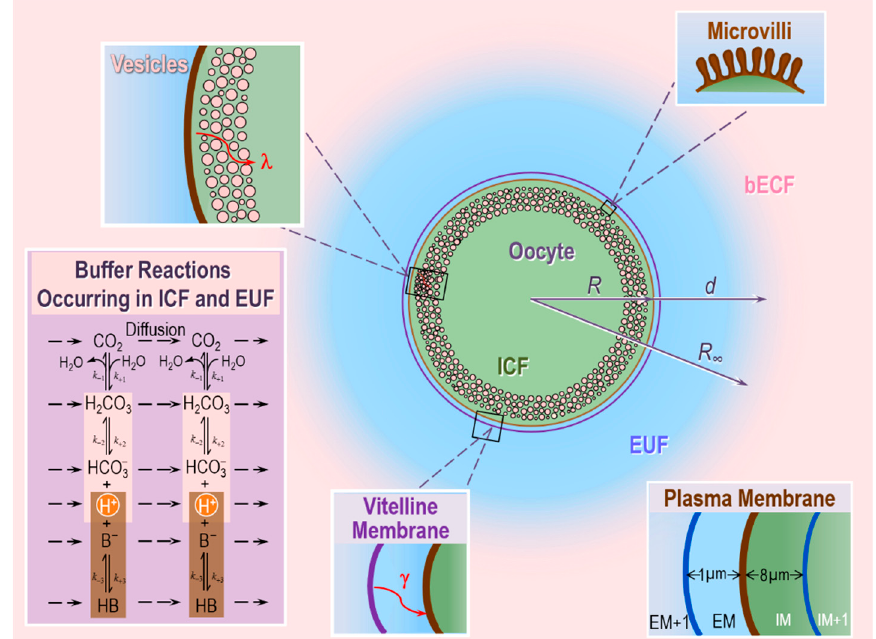
Figure 5 . Key elements of the reaction–diffusion mathematical model of CO 2 fluxes across the plasma membrane of an oocyte. The model includes: a thin layer of vesicles beneath the plasma membrane (inset in top left corner), folds and microvilli at the plasma membrane (PM; inset in top right corner), intracellular and extracellular buffer reactions (inset in bottom left corner), cytosolic water volume that is lower than total intracellular volume, lower diffusion constant for solutes in cytosol vs. extracellular fluid, and the vitelline membrane that envelops the PM (inset in bottom center). The inset in the bottom right corner illustrates the spatial discretization in the proximity of the PM. For additional details, see text. bECF, bulk extracellular fluid; EUF, extracellular unconvected fluid; ICF, intracellular fluid; EM, region immediately adjacent to the extracellular side of the plasma membrane; IM, region immediately adjacent to the intracellular side of the plasma membrane; R , radius of oocyte; R ∞ , radius of the computational domain; d , thickness of the EUF; λ and γ , tortuosity factors; k , reaction rate. Modified from Figure 1 of [79].